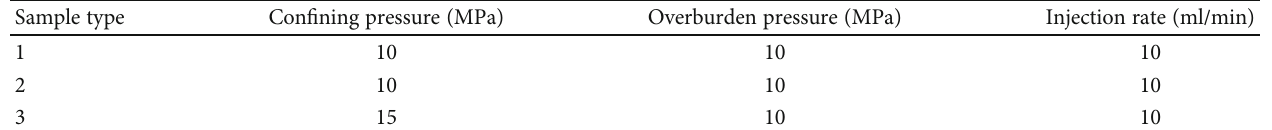
Table 2: Experimental design for fracturing on clayey-silt sediments.